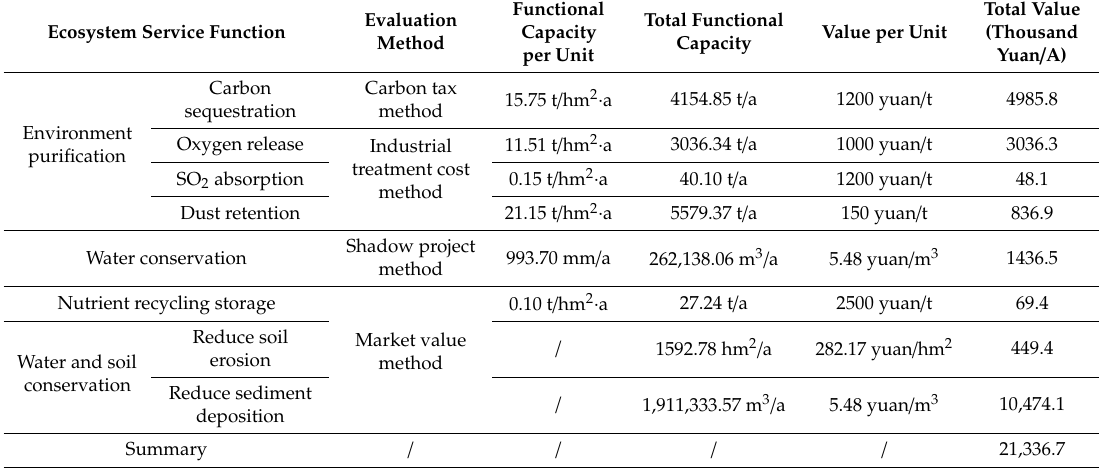
Table 2. Prediction of ecological service function in the mining ecological restoration area. Ecosystem Service